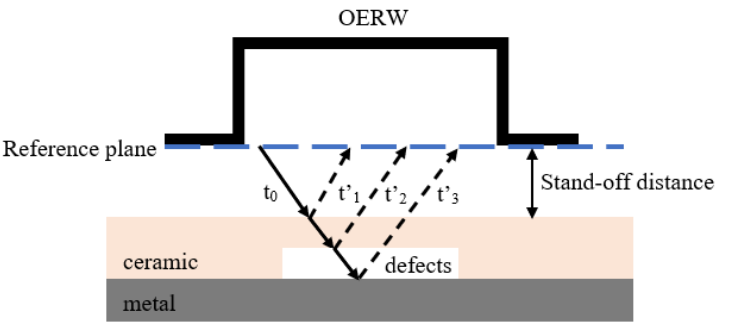
Figure 2. Cross-section of an OERW and the trellis diagram of the incident wave, with its multiple reflections, which are incident wave, t 0 , reflected wave from ceramic, delamination border and metal surface, t’ 1 , t’ 2 and t’ 3 , correspondingly, of a sample under test with delamination. The OERW uses frequency sweeping to operate. A frequency sweeping is used